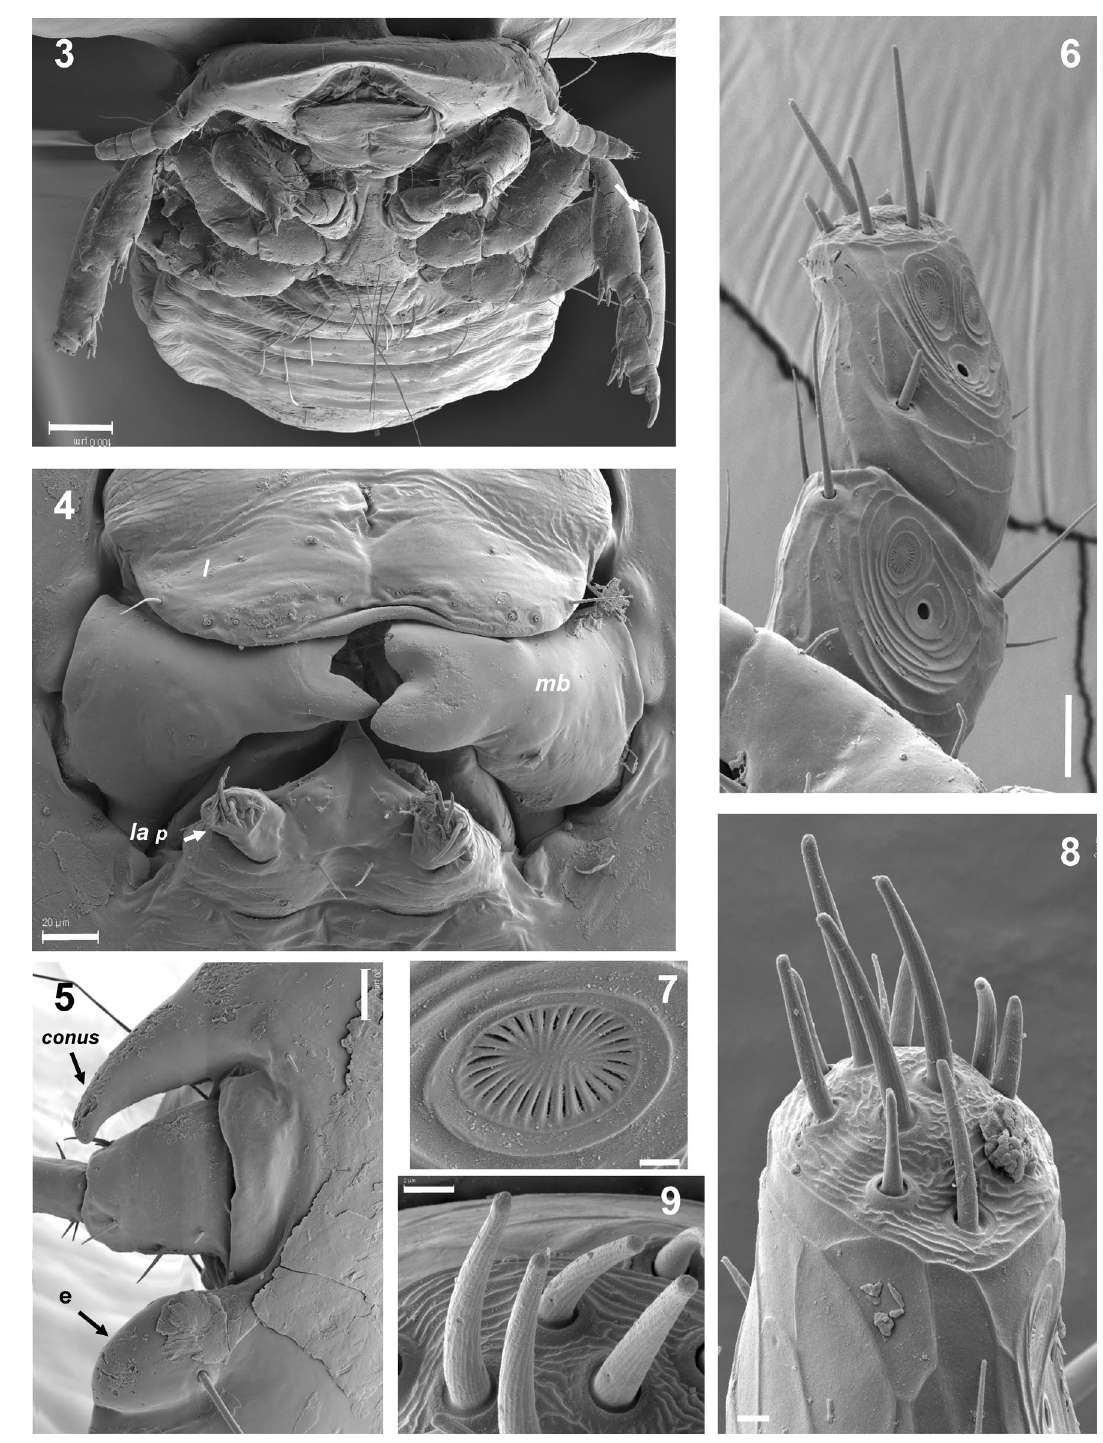
Figure 2. (3) Degeeriella punctifer . Frontal view of the head. Scale bar: 100 µm. (4) Degeeriella punctifer . Mandibles and labial palpi. Scale bar: 20 µm. (5) Degeeriella punctifer . Conus, antennal insertion and eye. Scale bar: 20 µm. (6) Degeeriella punctifer . Sensillae of the two distal segments of the antenna. Scale bar: 10 µm. (7) Degeeriella punctifer . Detail of a placoid sensilla. Scale bar: 1 µm. (8) Degeeriella punctifer . Detail of the tip of the antenna. Scale bar: 2 µm. (9) Degeeriella punctifer . Detail of the basiconic sensillae of the tip of the antenna. Scale bar: 2